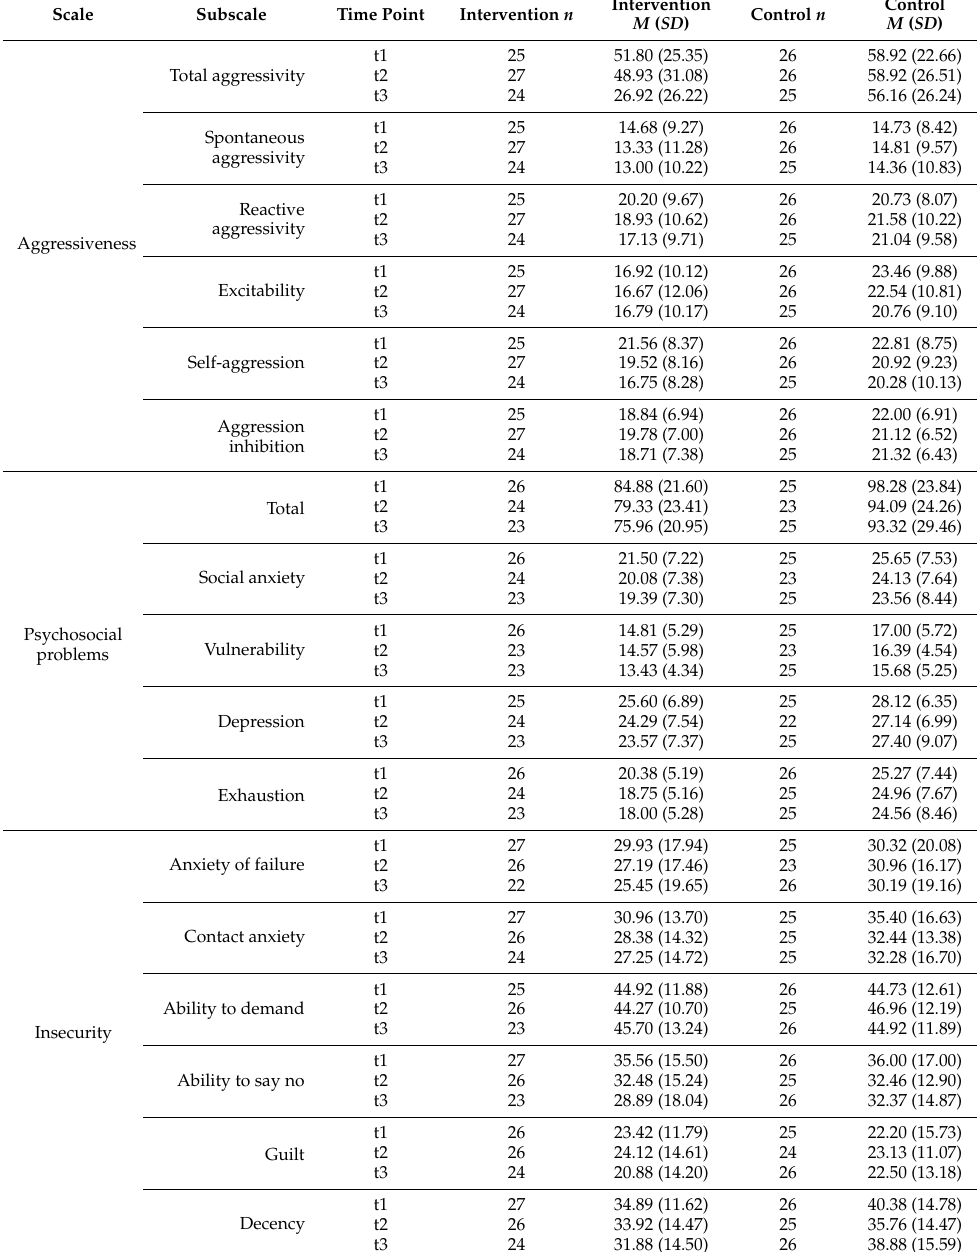
n = number, M = mean, SD = standard deviation. Table A2. Mood of the prisoners in the intervention group before and after the sessions.